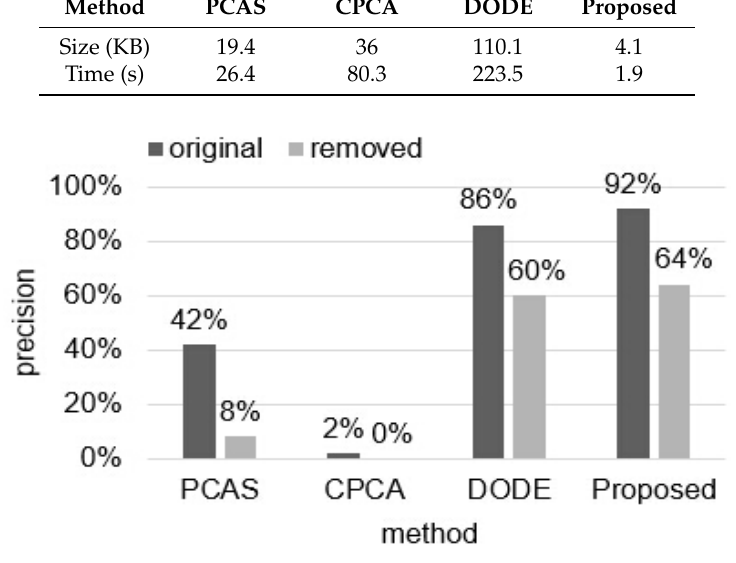
Figure 5. Precision of 3D model identification.